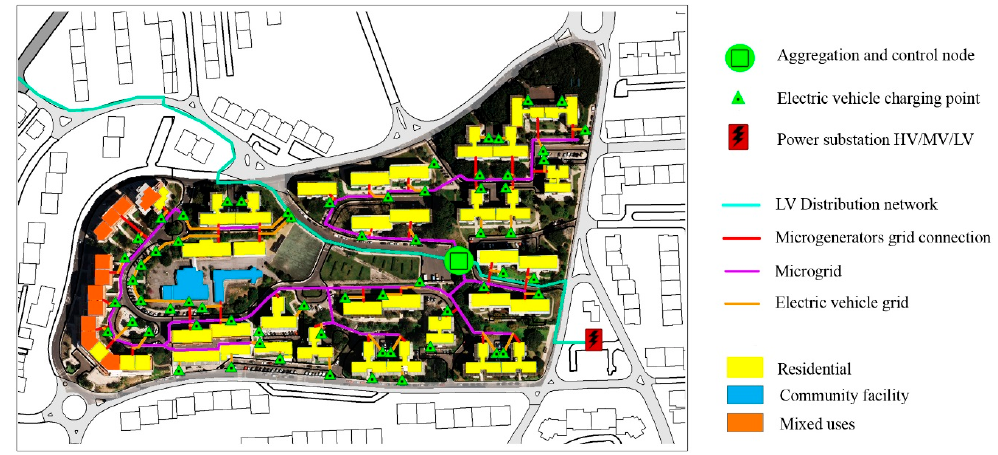
Figure 5. Layout of the ‘Produces and Drives’ scenario.